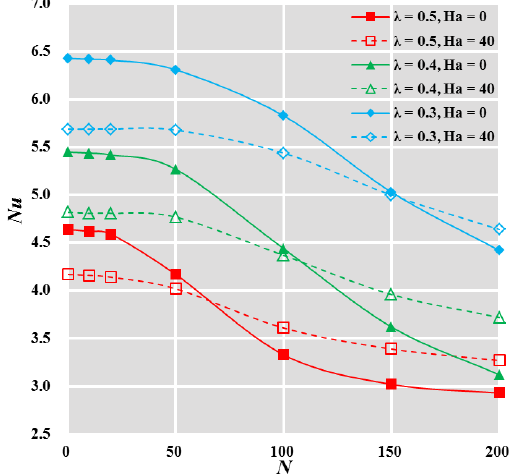
Figure 12. Effects of N on Nu in different cases.